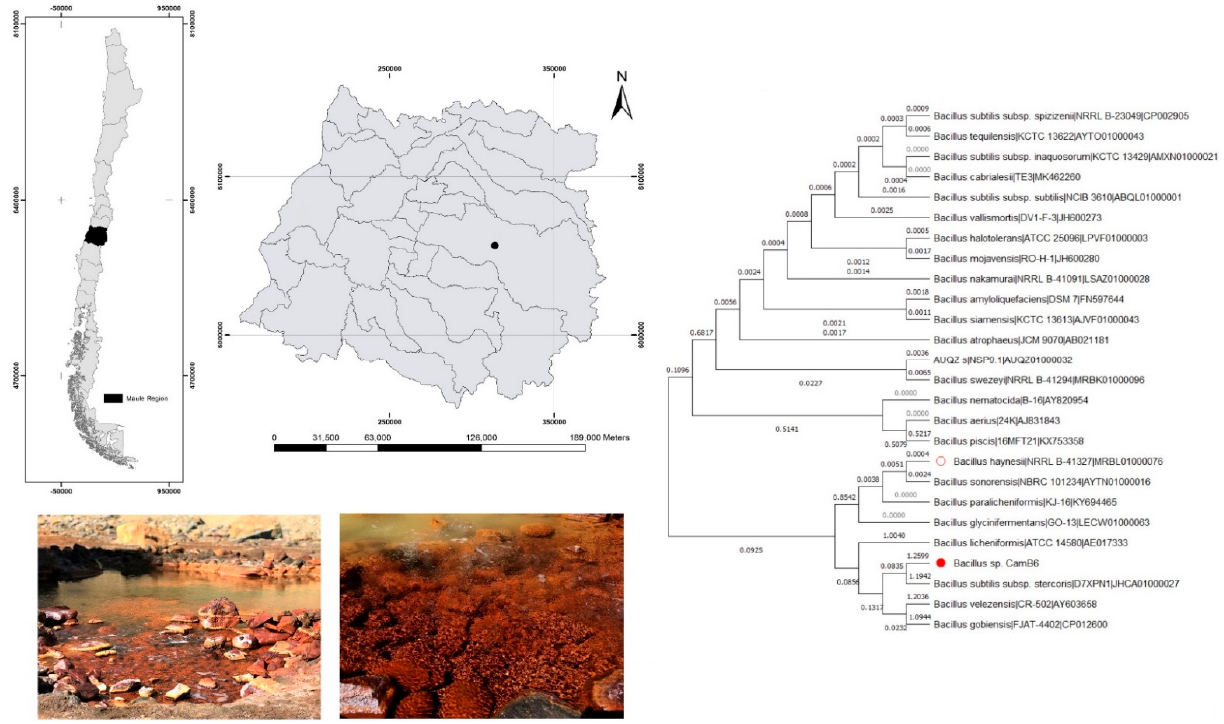
Figure 1. Map image showing the location of the Campanario hot spring located in the Andean Mountains in the Maule region, Chile, and photographs of the study site. On the right, the maximum likelihood phylogeny of isolate CamB6 (filled red circle) shows similarity with B . haynesii (outlined red circle).